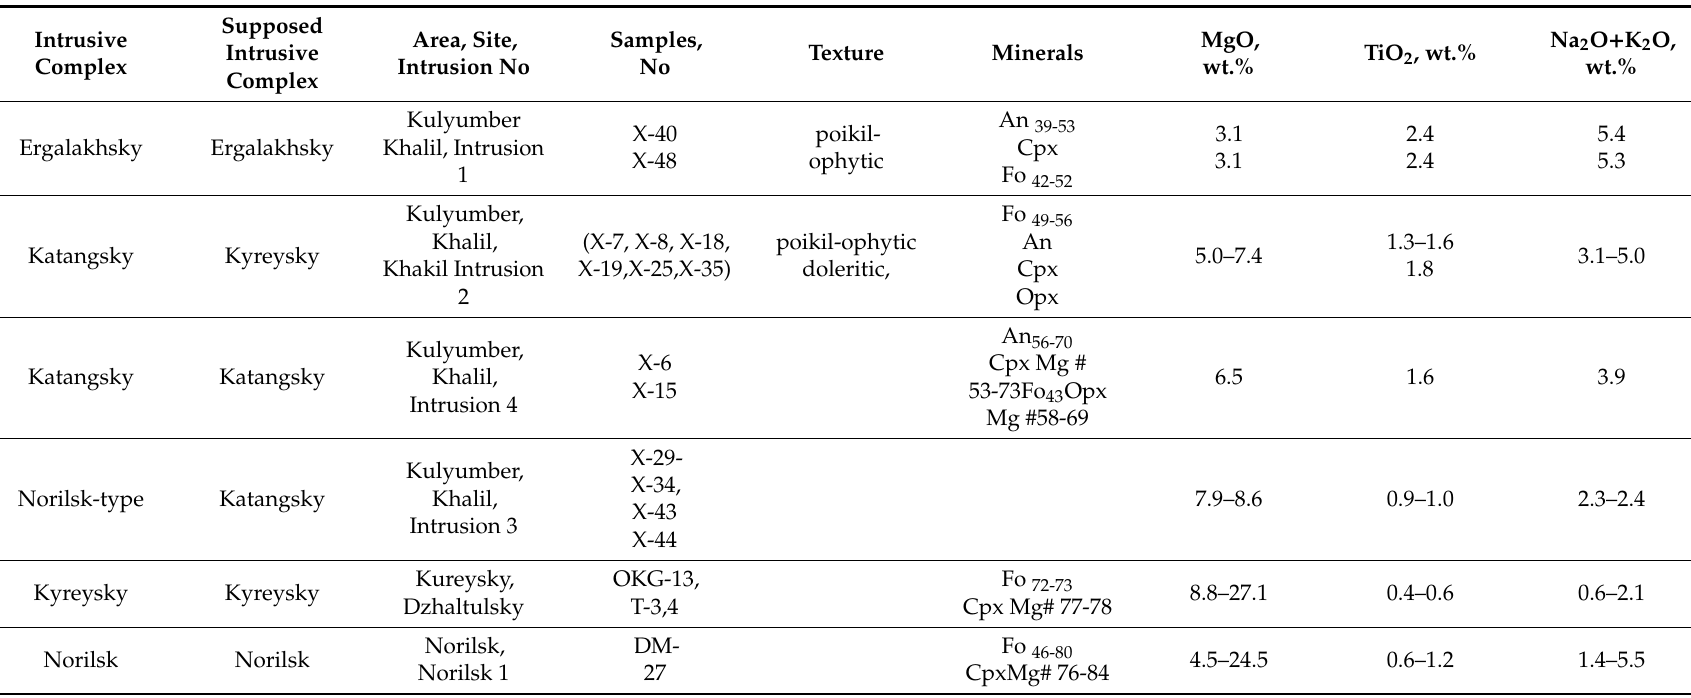
Table 7. Comparison of mineralogical and geochemical features of the intrusive